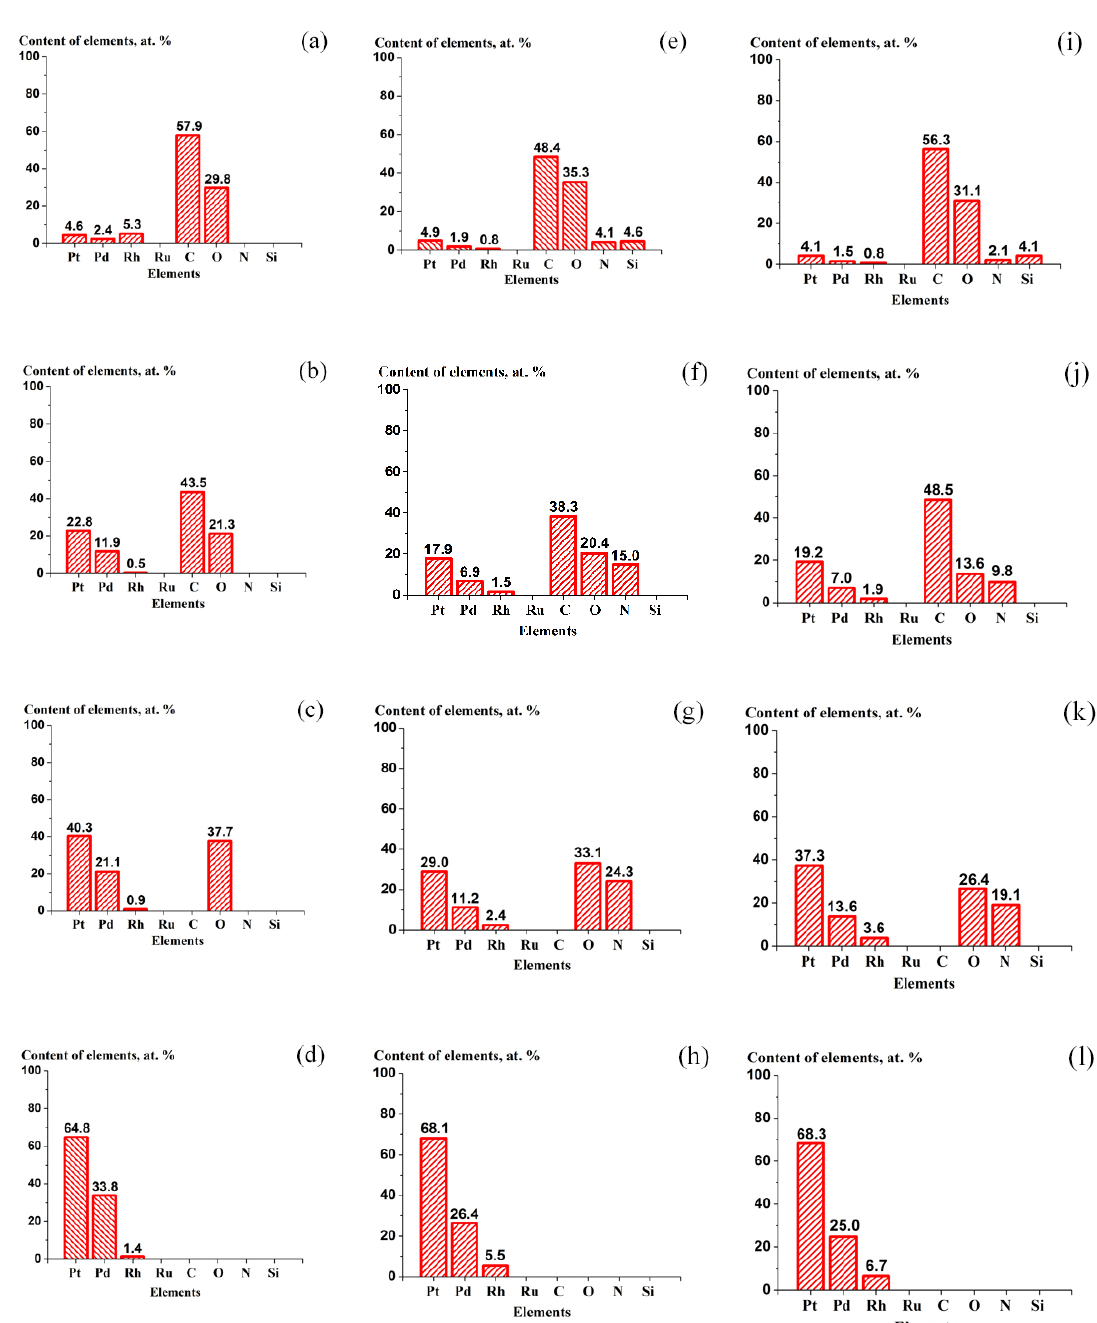
Figure 5. The content of elements measured by XPS in the surface layers of the new gauze ( a – d ) and also on the back ( e – h ) and frontal ( i – l ) sides of the gauze after NH 3 oxidation. ( a , e , i ) Concentrations of all the detected elements in the surface layer of gauzes. ( b,f,j ) Relative concentrations of elements